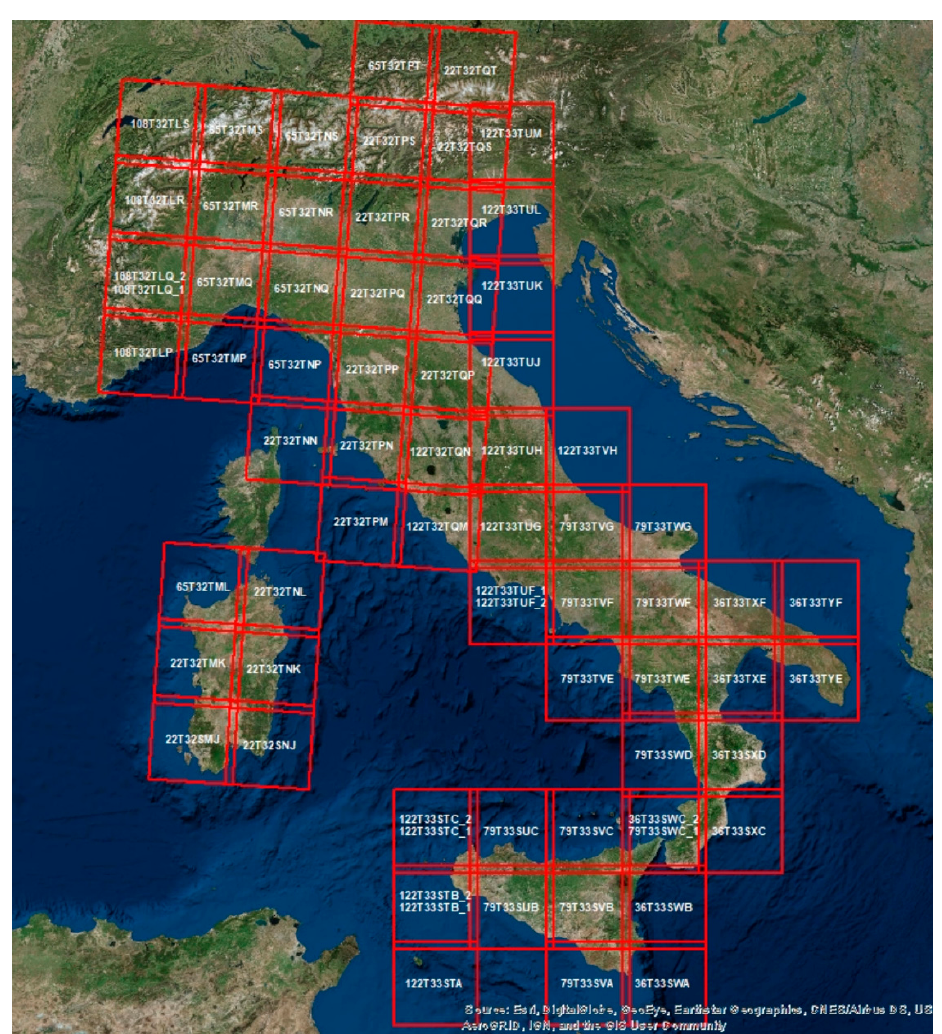
Figure 1. Sentinel-2 tiles, covering the Italian territory and processed by AUTOBAM.